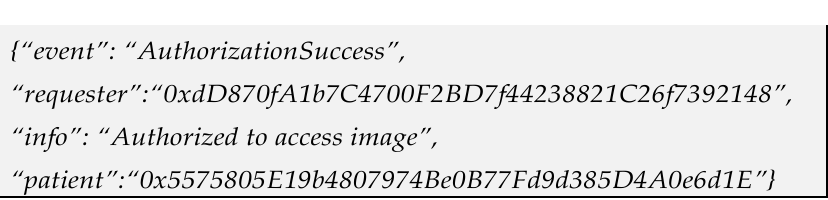
Figure 8. Case 3: event log stored in the blockchain. Information shows that the IR 1 address was authorized to access a patient medical image.